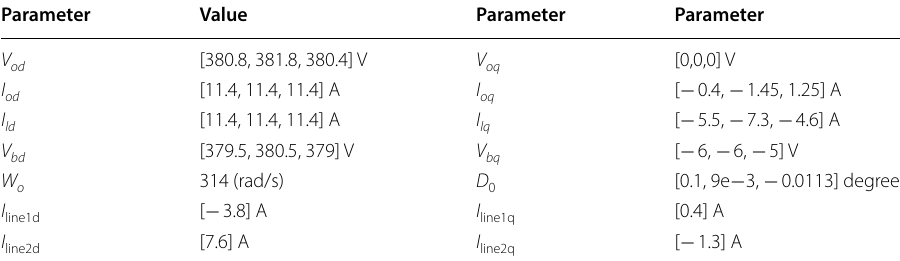
Table 2 Initial conditions of